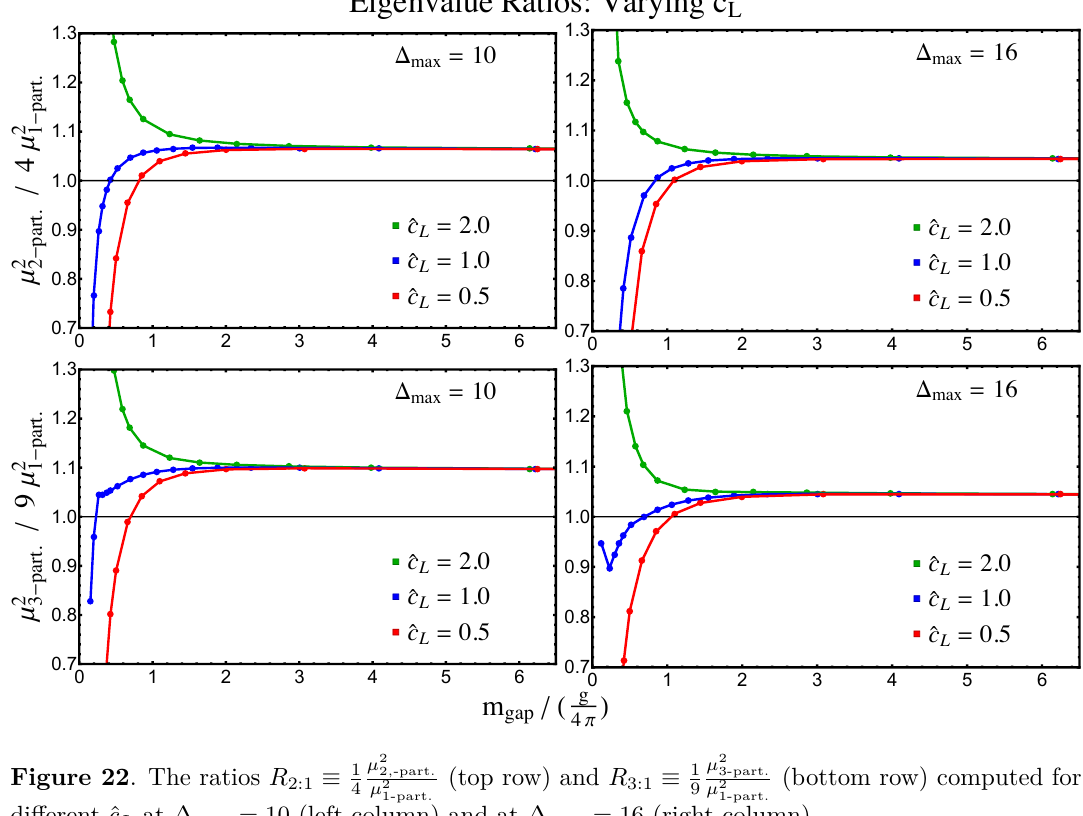
µ 2 2 , -part. µ 2 3 -part. (top row) and R (bottom row) computed for 1 Figure 22 . The ratios R 2:1 ≡ 1 3:1 ≡ 4 9 µ 2 1 -part. µ 2 1 -part. different ˆ c at ∆ = 10 (left column) and at ∆ = 16 (right column). L max max chose ˆ c = 1 as a generic value in this range. In the ∆ → ∞ limit, we expect that max L